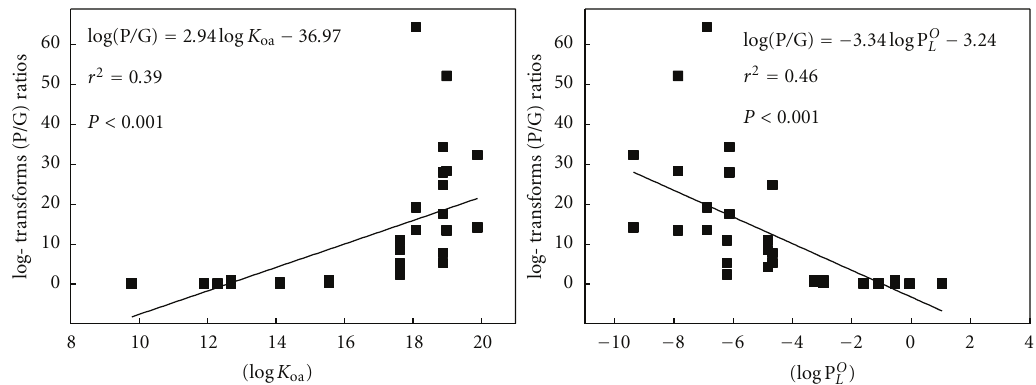
Figure 6: Relationships between log(P/G) and log K Oa as well as log P O